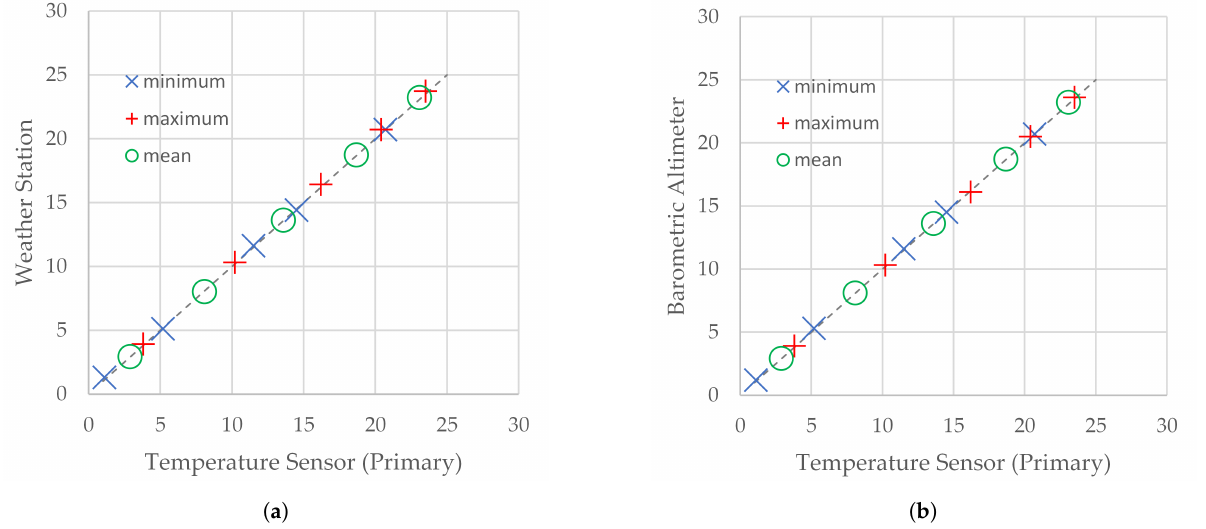
Figure 4. Scatter plots for statistics of temperature measured by a reference device and the primary temperature sensor of the flying weather station. Reference device: ( a ) the SBS-WS-400 weather station; ( b ) barometric